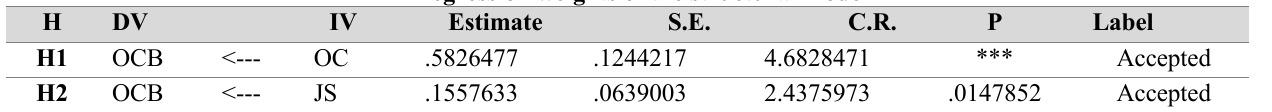
Regression weights of the structural